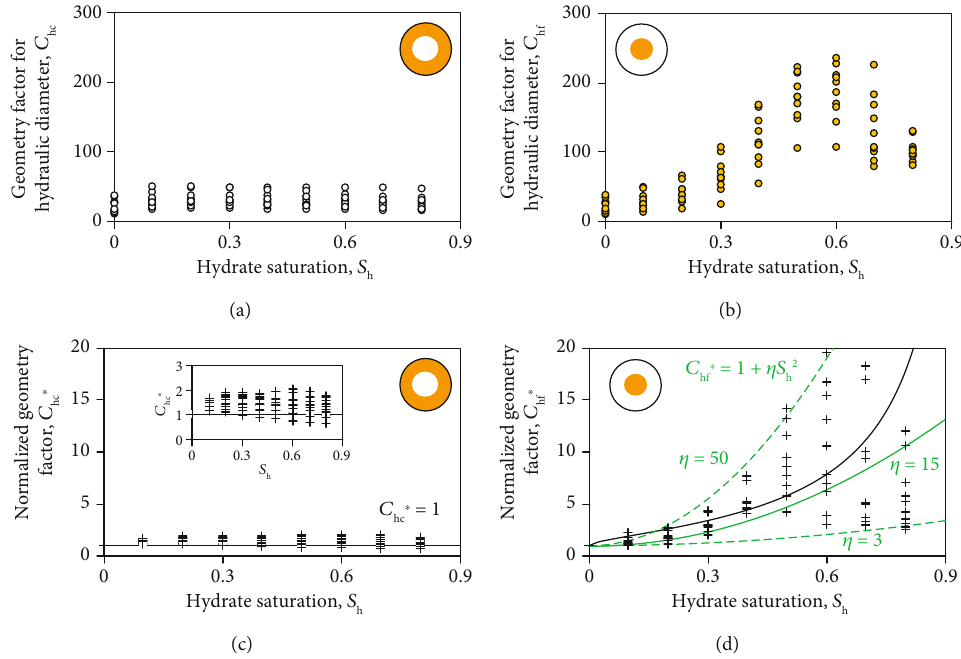
∗ for hydraulic diameter evolving with hydrate saturation S c Figure 8: Geometry factors c h and normalized geometry factors h factor for hydraulic diameter c hc in porous media containing grain-coating hydrates. (b) Geometry factor for hydraulic diameter c hf in porous media containing pore- fi lling hydrates. (c) Normalized geometry factor for hydraulic diameter c hc ∗ in porous media containing grain-coating hydrates. (d) Normalized geometry factor for hydraulic diameter c hf ∗ in porous media containing pore- fi lling hydrates. The black curve is p ffiffiffiffiffi p ffiffiffiffiffi Þ / ð 1 − S Þ S drawn by c hf ∗ = ð 1 + h h